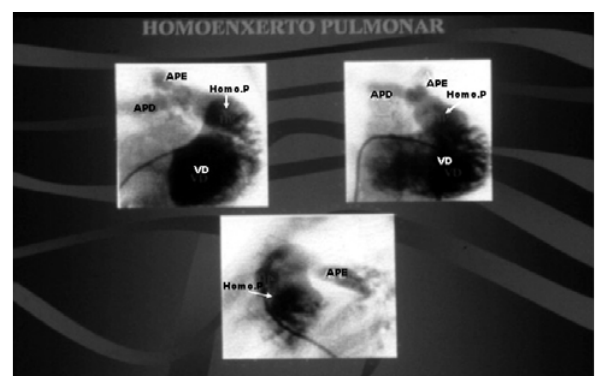
Fig. 8 - Estudo hemodinâmico pós-operatório. Ventriculografia direita contrastando o homoenxerto pulmonar (Homo. P) e as